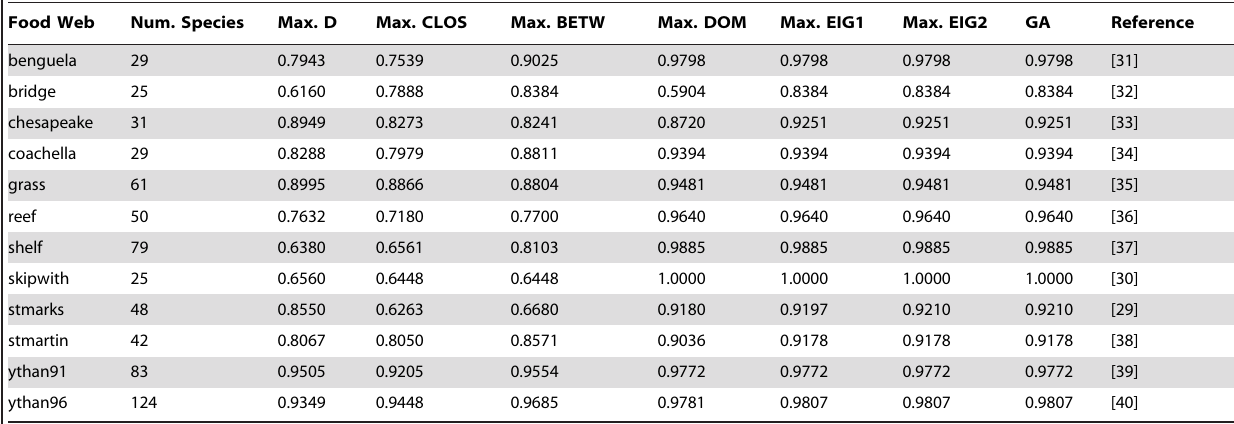
Table 1. Extinction